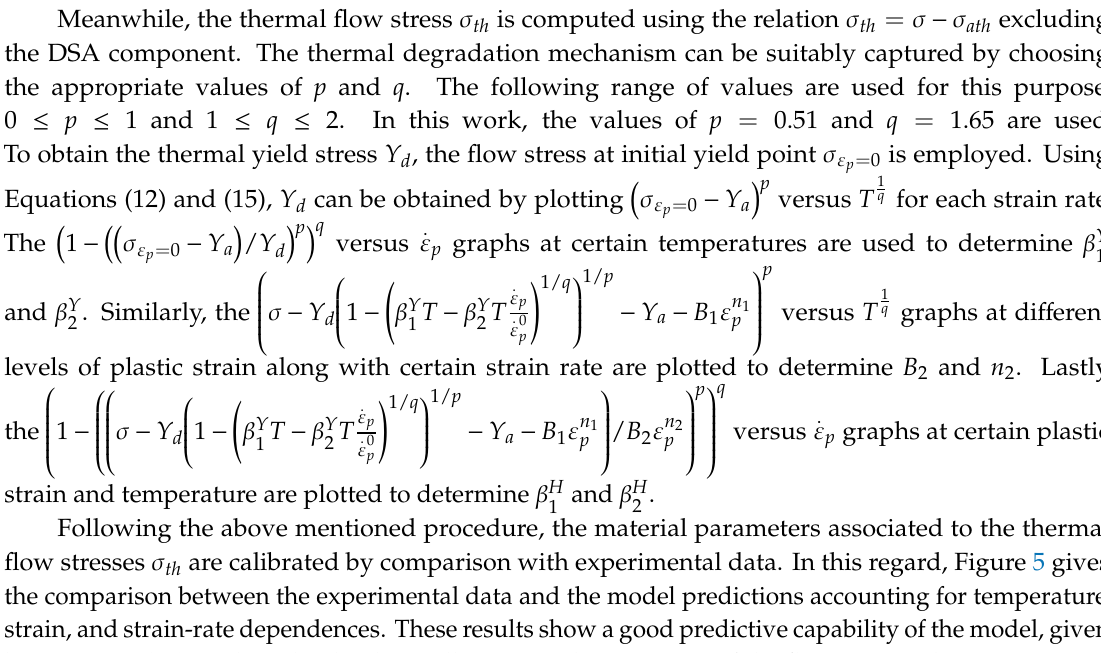
Table 1. Material parameters used in the Voyiadjis–Abed (VA) model for Q235B. (cid:1851) ((cid:1839)(cid:1842)(cid:1853)) (cid:1828) ((cid:1839)(cid:1842)(cid:1853)) (cid:3028) (cid:2869)